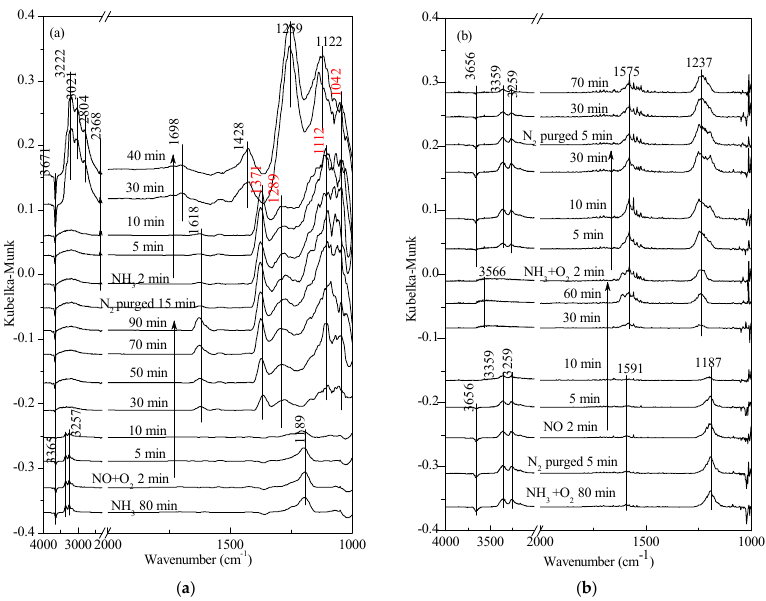
Figure 6. In situ DRIFTS spectra of the transient reactions at 250 °C between ( a ) NO + O 2 and pre-adsorbed NH 3 , and ( b ) NO and pre-adsorbed NH 3 + O 2 species over 1 wt. % V 2 O 5 -0.2CeO 2 /TiO 2 -ZrO 2 catalysts recorded as a function of time.